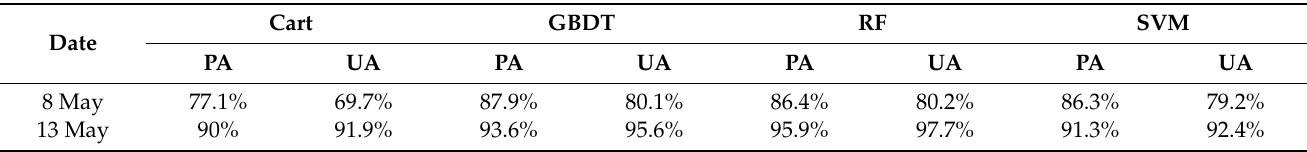
Table 7. Maximum PA and UA of rice in 2020 different periods.